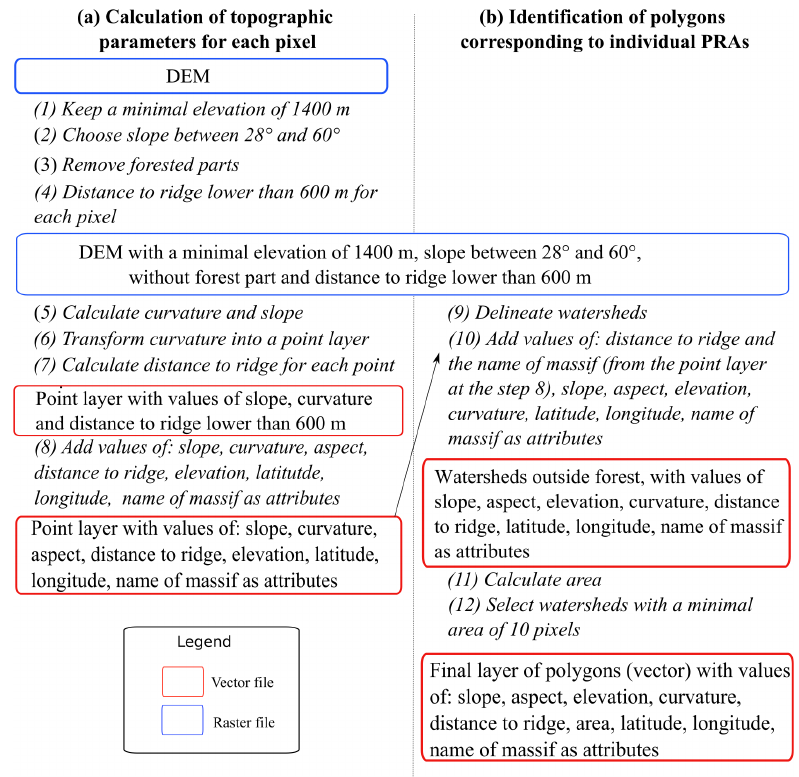
Figure 3. The 12 steps of the proposed PRA detection method. Calculations at (a) the pixel scale and (b) the scale of identified